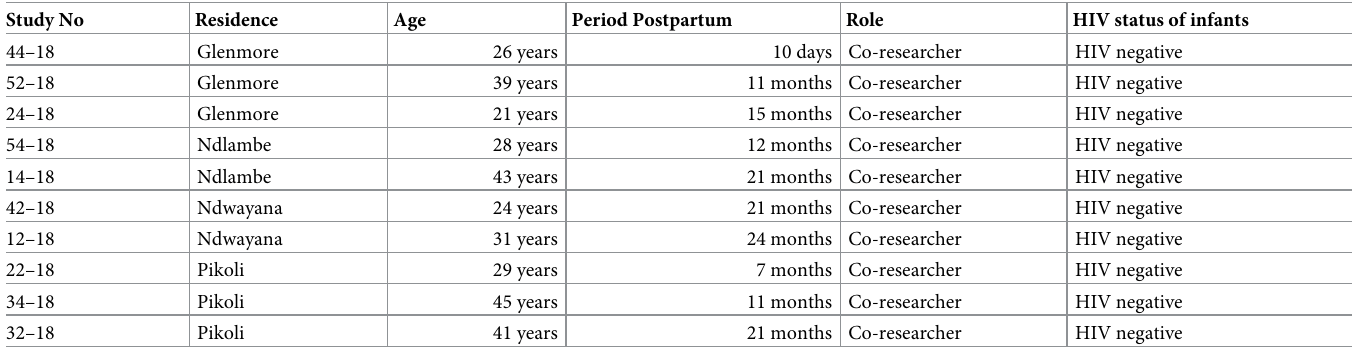
Table 1. Status of the ten